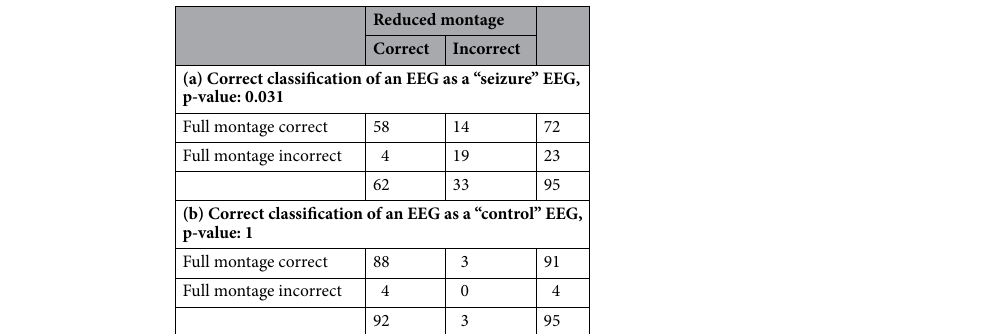
Table 2. The contingency tables comparing the correctness rates on the seizure and control EEGs.